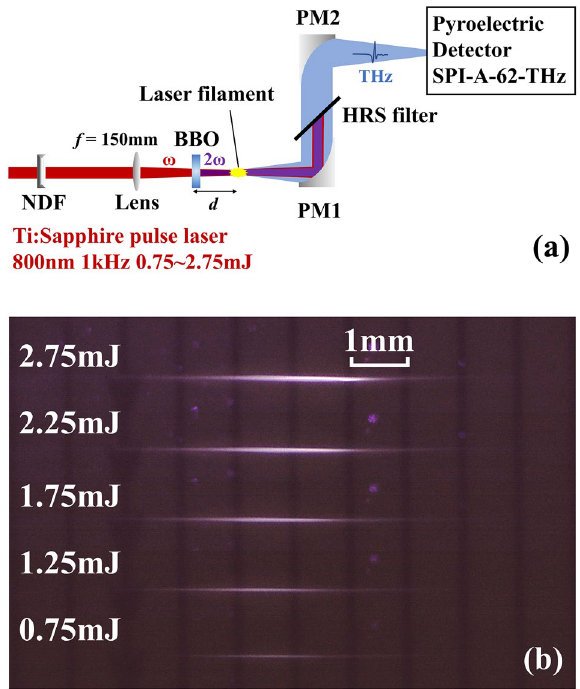
Figure 1. Schematic setup of a dual-color laser filament THz generation system. ( a ) Infrared 800 nm pulse from amplified Ti:Sapphire laser system and its second harmonic ( ω and 2 ω ) converted with a 0.1 mm type-I β-BaB 2 O 4 (BBO) co-focused on air at standard atmospheric pressure to form a laser filament as shown in ( b ). The distance d between the BBO crystal and the laser filament is adjusted by a linear stage. After the filament, ω , 2 ω and emitted THz pulses are collected by a parabolic mirror (PM1). The ω and 2ω pulses are then filtered by a high-resistance silicon (HRS) wafer, the THz pulses are focused by another parabolic mirror (PM2), and the pulse energy is measured by a pyroelectric detector (SPI-A-62-THz). ( b ) CCD images of filaments taken at corresponding incident pulse energies adjusted by a circular variable neutral density filter